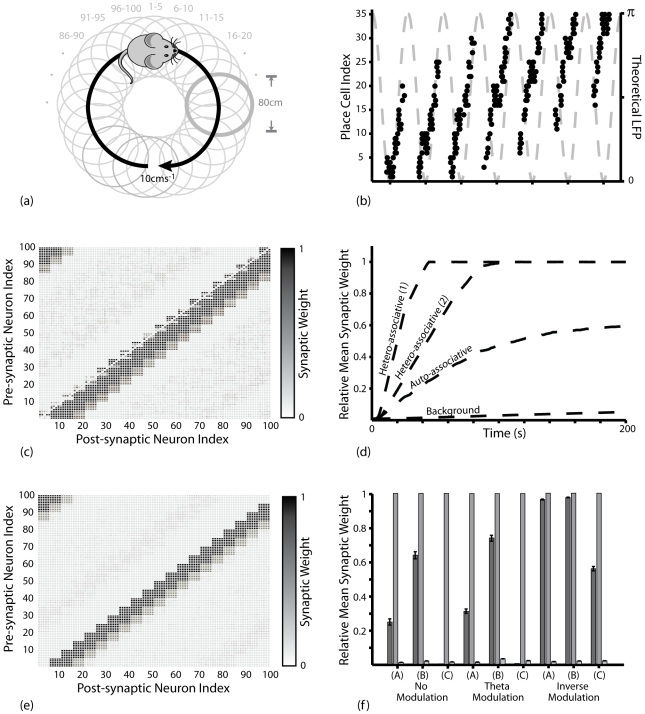
Dual Coded Learning in a Spiking Recurrent Neural Network.(a) Theoretical details of dual coding simulations. 20 equidistant and overlapping place fields of 80cm diameter, offset by 10cm, form a circular route that is traversed repeatedly at a constant speed of 10cms−1. Each place field is encoded by five place cells. (b) Representative spike raster in thirty-five place cells encoding for seven separate but overlapping place fields. Place cells encoding for different place fields fire stochastically within different theta phase windows. (c) Typical synaptic weight matrix following ten traversals of the route for the BCM type STDP rules. Synaptic connections between place cells that encode for successive place fields on the theoretical route saturate at the upper weight bounds and synaptic connections between place cells that encode for the same place field are selectively and significantly potentiated. Data illustrated for triplet-based STDP with theta modulated plasticity. (d) Dynamic changes in the relative mean weight (w/wmax) of auto-associative (between place cells encoding for the same place field), hetero-associative (between place cells encoding for a place field and that either one or two steps further along the route), and background (between place cells and those encoding for place fields not within three steps further along the route) connections. Data illustrated is for the triplet-based BCM type STDP rule with theta modulated plasticity. (e) Typical synaptic weight matrix following ten traversals of the route when the non-BCM type STDP rule is employed with theta modulated plasticity. In contrast to (c), auto-associative connections between place cells that encode for the same place field are depressed, while hetero-associative connections between place cells that encode for successive place fields saturate at the upper weight bounds. (f) The relative mean weight of synapses connecting each place cell to those that encode for the same place field (dark grey), the next place field on the learned route (medium grey), and all place fields not within three steps ahead on the learned route (light grey) following ten traversals, averaged over 50 separate simulations, with the pair- and triplet- based BCM type STDP rules (A and B respectively) and the non-BCM type STDP rule (C).